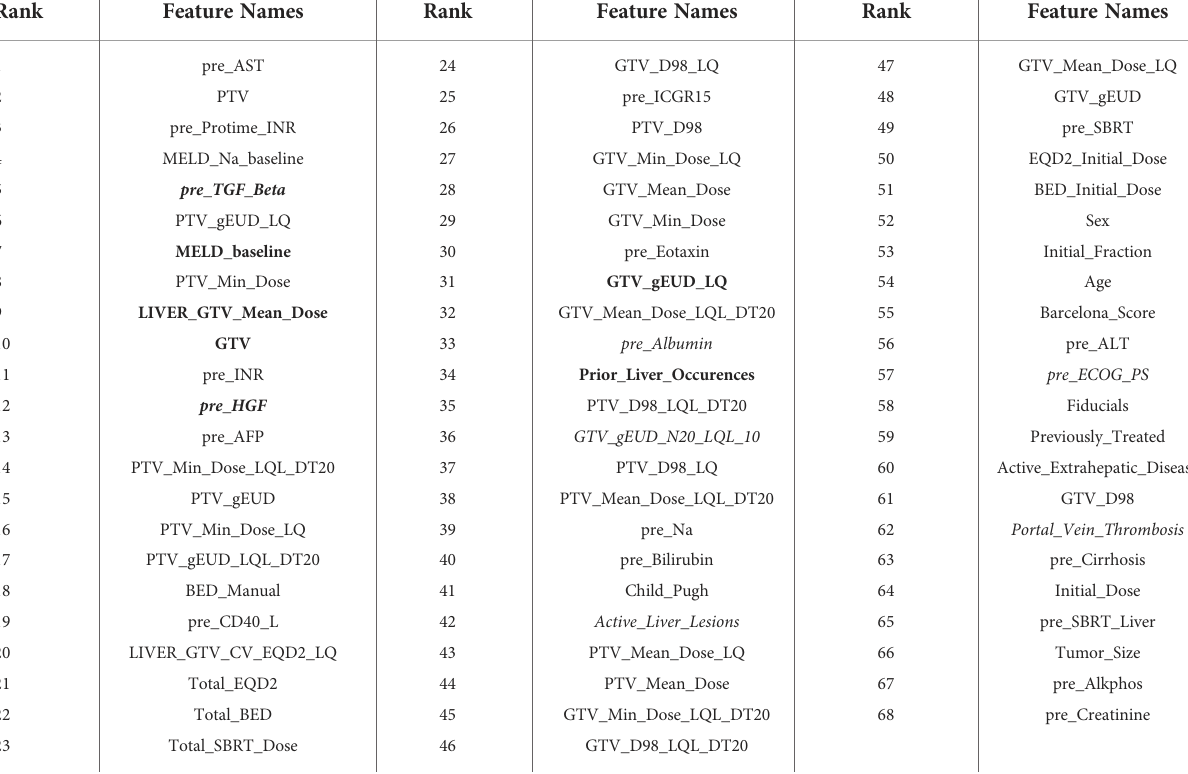
TABLE 5 The rank of features in an integrated feature ranking list for pre-treatment LC prediction.